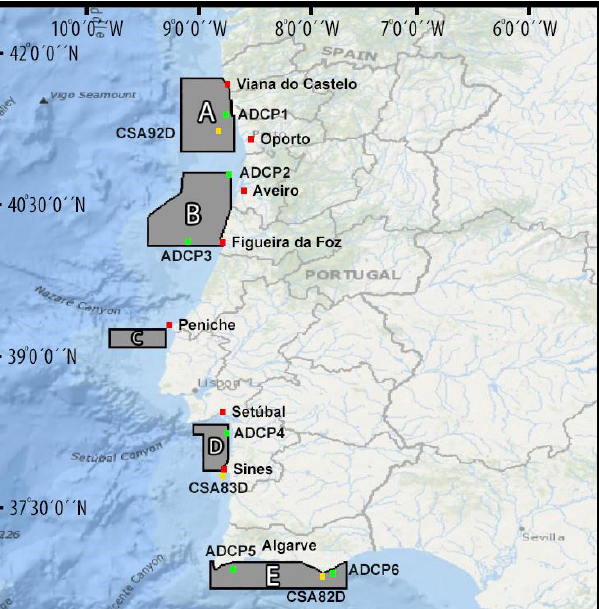
Figure 1. Map of the 5 study areas from the Aquimar project (A — Area A (between Viana do Castelo and Oporto); B — Area B (between Aveiro and Figueira da Foz); C — Area C (Peniche); D — Area D (between Setúbal and Sines); E — Area E (Algarve region); ( main cities near the surveyed areas); Wave buoys stations : CSA92D; CSA83D and CSA82D; Currents stations : ADCP1, ADCP2, ADCP3, ADCP4, ADCP5, and ADCP6).